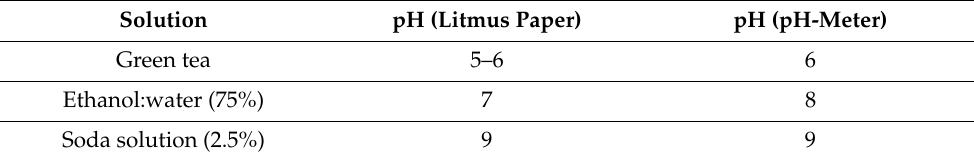
Table 2. The results obtained during the pH measurement of the